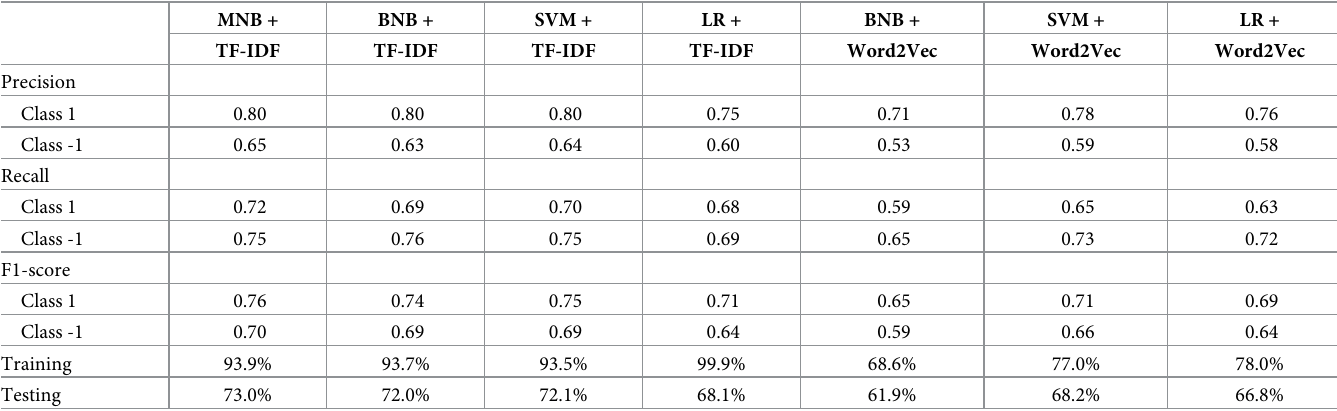
Table 1. Performance of different classifiers on the testing